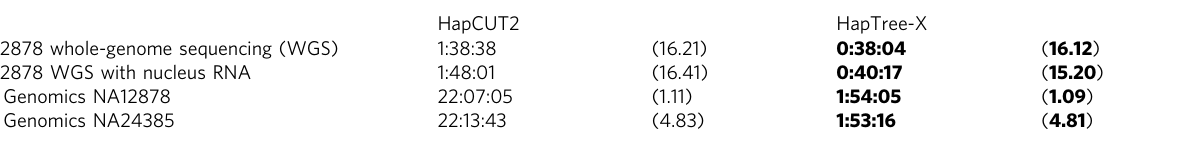
Cells contain runtime and switch error rate (in parenthesis). Bold values represent the best overall results for a metric in the dataset. HapTree-X is from 3 to 10× faster than HapCUT2 while providing better or comparable switch rates. Time units are in h:mm:ss.